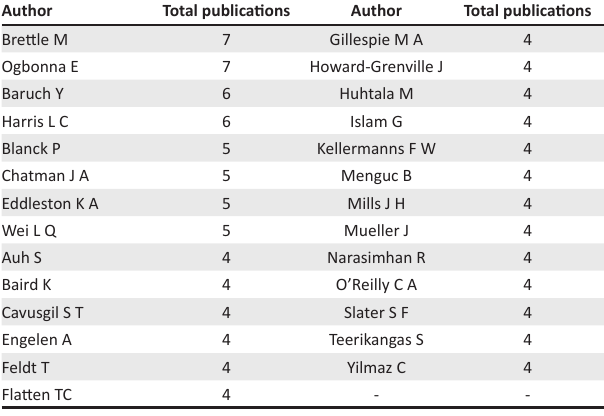
TABLE 2: The top 27 most productive